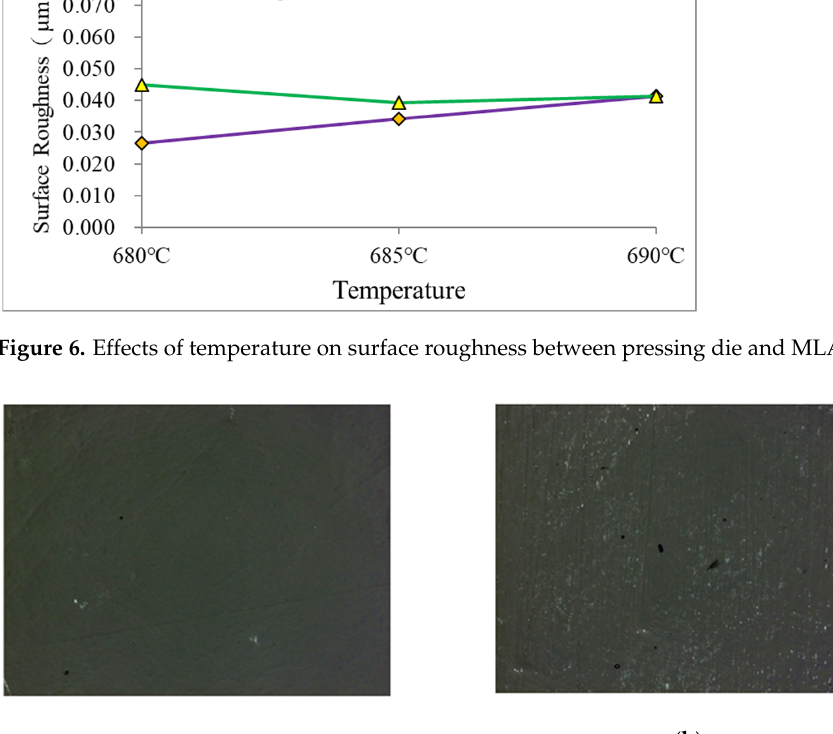
Figure 8. Effects of pressing force on surface roughness between pressing die and MLA. ( a ) ( b ) Figure 9. SEM diagrams at different molding pressure: ( a ) F = 210 N; ( b ) F = 250 N. 3.2. Polishing Effects with or without Ultrasonic Polishing on Surface Roughness and Material Removal By virtue of the fact that it is difficult to polish the surface of pressing dies with sine- waved shapes, in order to obtain a relatively smooth and precise surface, an efficient and feasible technique is represented by ultrasonic polishing using the high-frequency